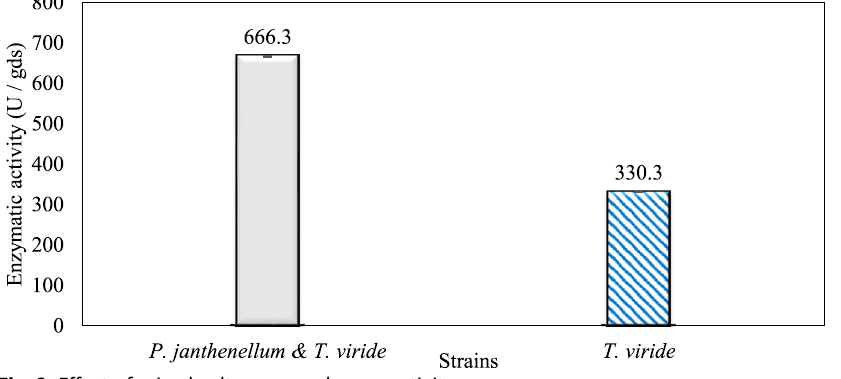
Fig. 9. Effect of mixed cultures on xylanase